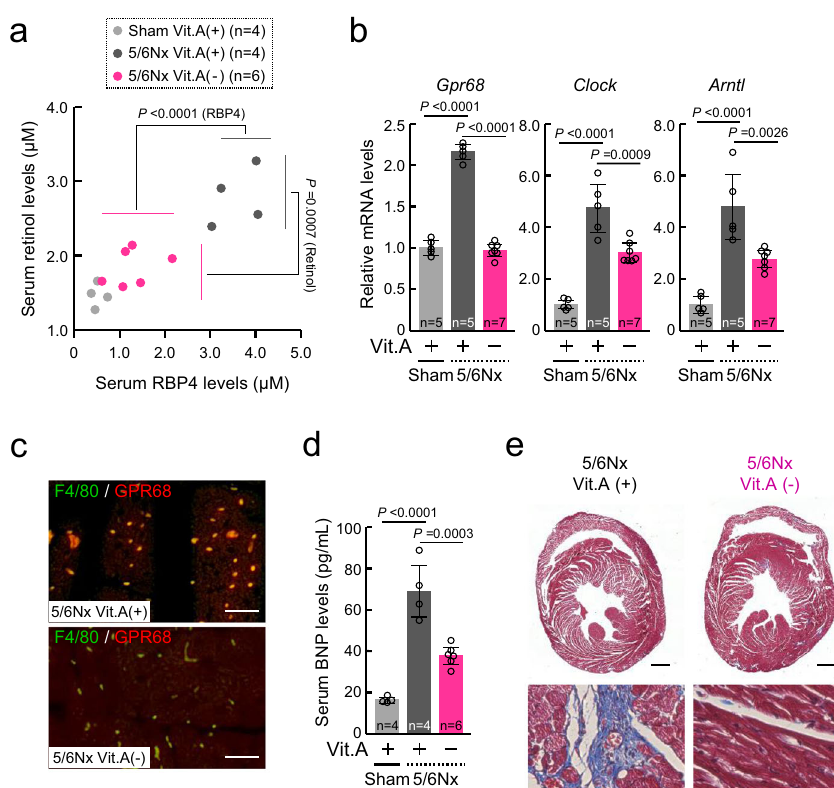
Fig. 7 Vitamin A-free diet reduces GPR68 expression in monocytes in 5/6Nx mice. a Correlation between serum retinol and RBP4 levels in 5/6Nx mice fed with normal or vitamin A-free diet. b Dietary de fi ciency of vitamin A suppresses the upregulation of Gpr68 , Clock , and Arntl mRNA levels in circulating monocytes. The mean value of the Sham group was set as 1.0. c Double immuno fl uorescence labeling of GPR68 with F4/80 in the ventricle slices prepared from 5/6Nx mice fed with normal or Vitamin A-free diet. High-GPR68-expressing cells are double-labeled (yellow) with F4/80. The scale bar indicates 50 μ m. d Serum BNP concentrations in Sham and 5/6Nx mice fed with normal or vitamin A-free diet. e Dietary de fi ciency of vitamin A ameliorates CKD- induced cardiac fi brosis. The Masson ’ s trichrome staining show tissue fi brosis in blue. Scale bars indicate 1 mm (upper panel) and 50 μ m (lower panel). For all panels, graphs show the mean ± SD of individual mice in independent experiments. Statistical signi fi cance was determined using one-way ANOVA with Tukey – Kramer post hoc tests ( a , b , d ). Numbers and P -values are shown in each graph. Source data are provided as a Source Data fi